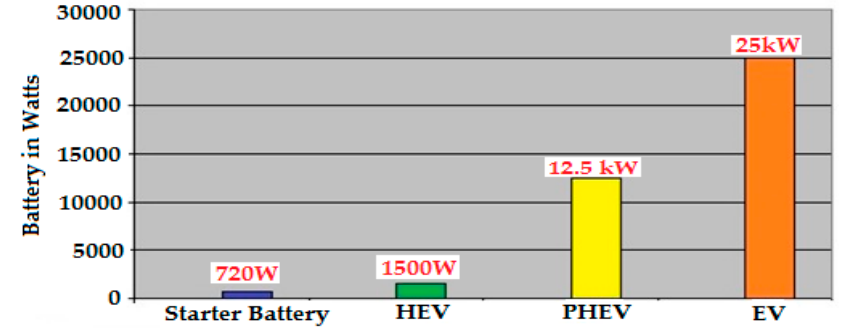
Figure 1. Electric propulsions versus energy consumption.